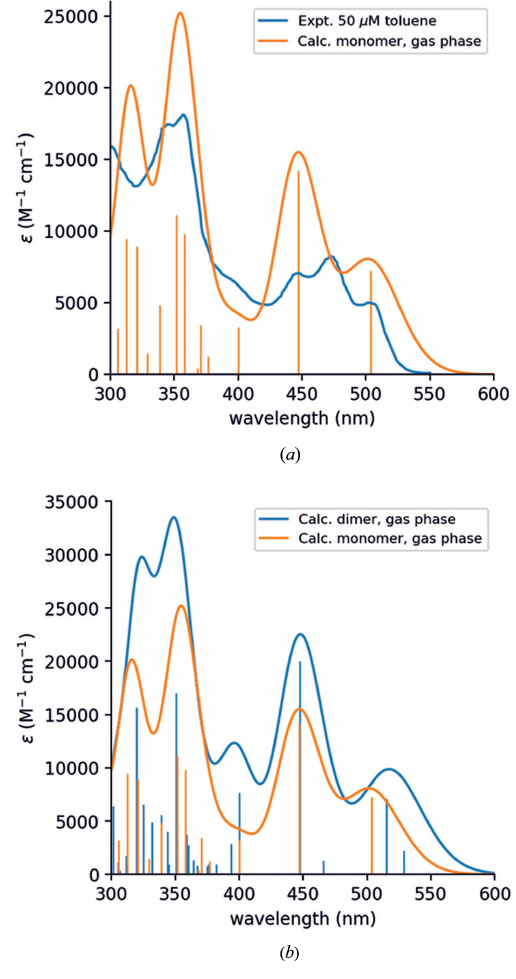
Figure 8 ( a ) Absorption spectra of the TAAP monomer in the gas phase, computed at the TD-DFT/B3LYP level (shifted by (cid:7) 0.33 eV), compared to the experimental absorption spectra of TAAP in toluene (50 m M ). ( b ) Absorption spectra of the TAAP monomer and dimer in the gas phase, computed at the TD-DFT/B3LYP level (shifted by (cid:7) 0.33